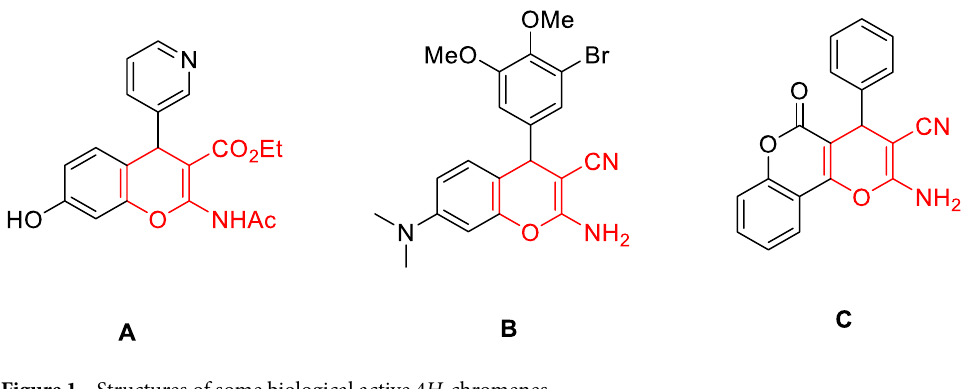
Figure 1. Structures of some biological active 4 H